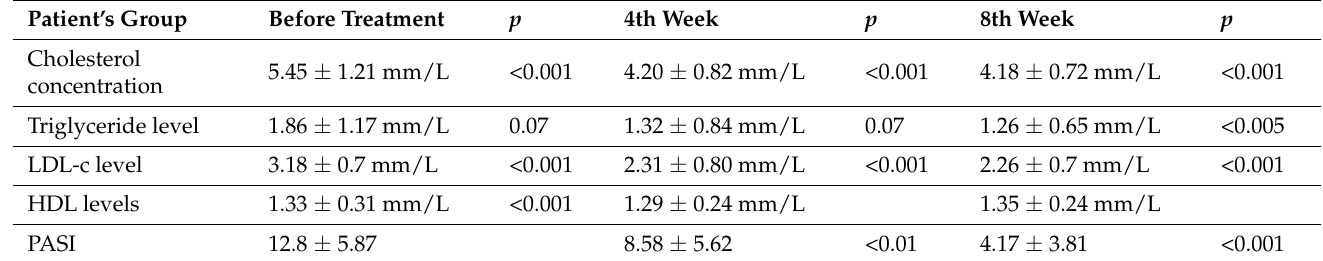
Figure 2. Major pharmacological effects of statins. Table 3. Results of treatments with statins reported by Trong et al. Table 2. Speci fi c information about the pharmacological e ff ects of statins [1,7–21].